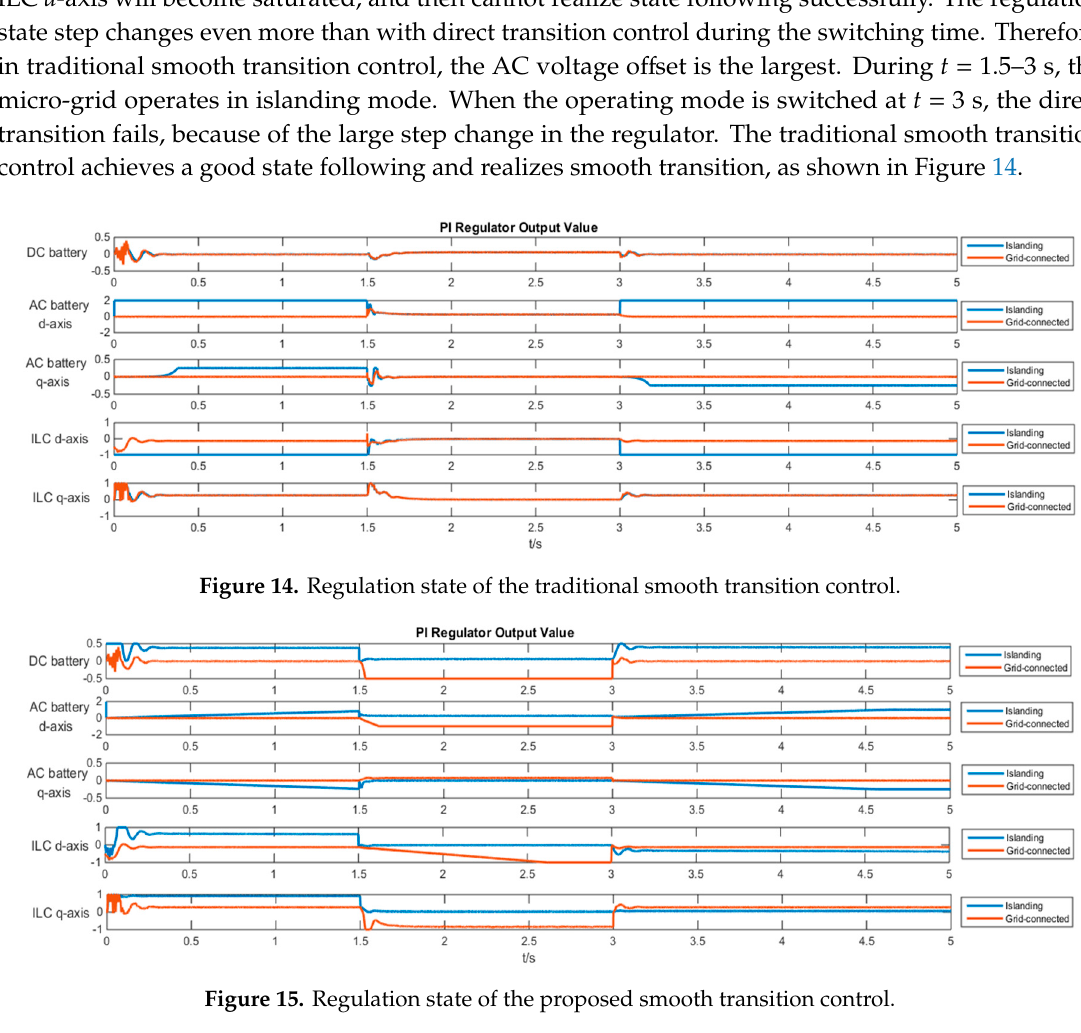
Figure 15. Regulation state of the proposed smooth transition control.